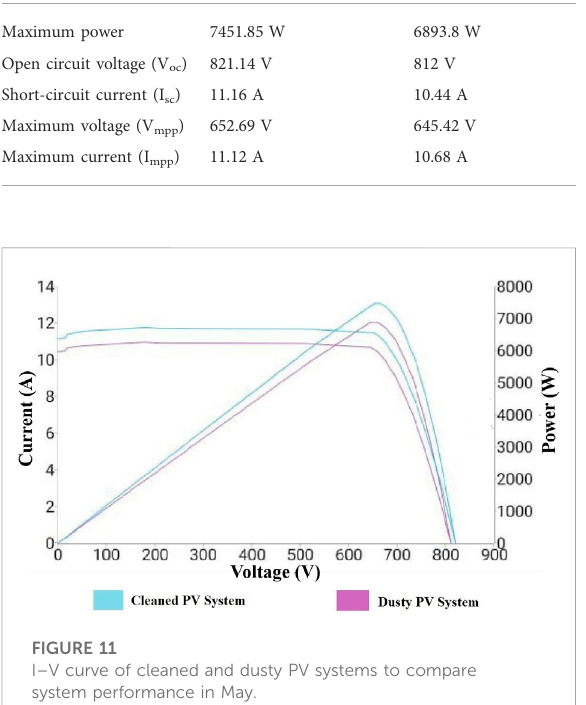
FIGURE 11 I – V curve of cleaned and dusty PV systems to compare system performance in May.